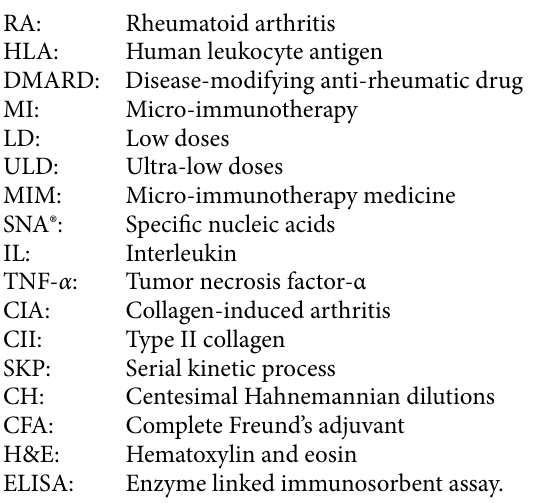
Figure S1. Representative histologic sections of knee joints of three animals per group stained with H&E from normal (1a–3c), CIA (4a–6c), vehicle (7a–9c) and MIM-treated mice (10a–12c) are shown. The magnification of the images in the first row was taken at 4x, whereas in the second and third row were taken at 10x. Black circles indicate inflammation and synovial hyperplasia. Green circles show articular car- tilage loss. T=Tibia; F=Femur; C=Cartilage layer; JS=Joint space; E=Epiphyseal growth plate. Figure S2. Representative histologic sections of knee joints of three animals per group stained with Safranin-O from normal (1–3), CIA (4–6), placebo-treated (7–9) and 2LARTH-treated mice (10–12) are shown. The magnification of the images was taken at 4x and 10x. The areas with cartilage appear red colour